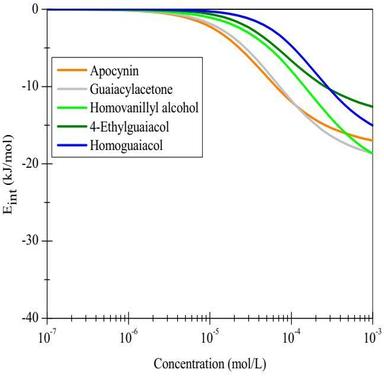
Evolution of the internal energy versus the concentration for the five studied systems.